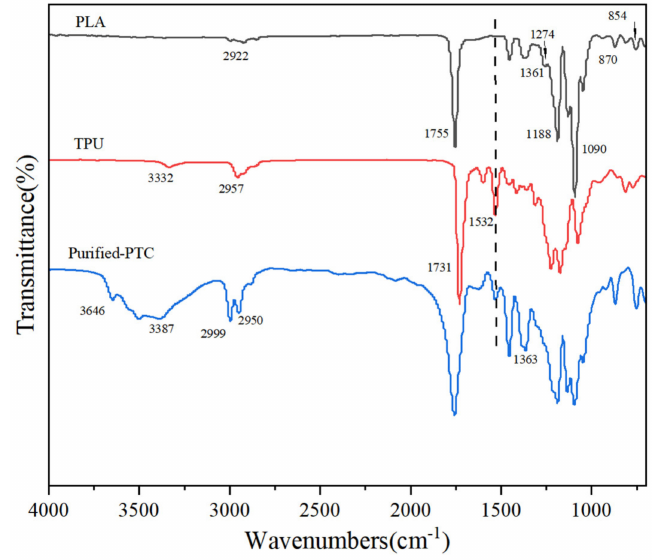
Figure 2. FTIR spectrum of PLA, TPU and